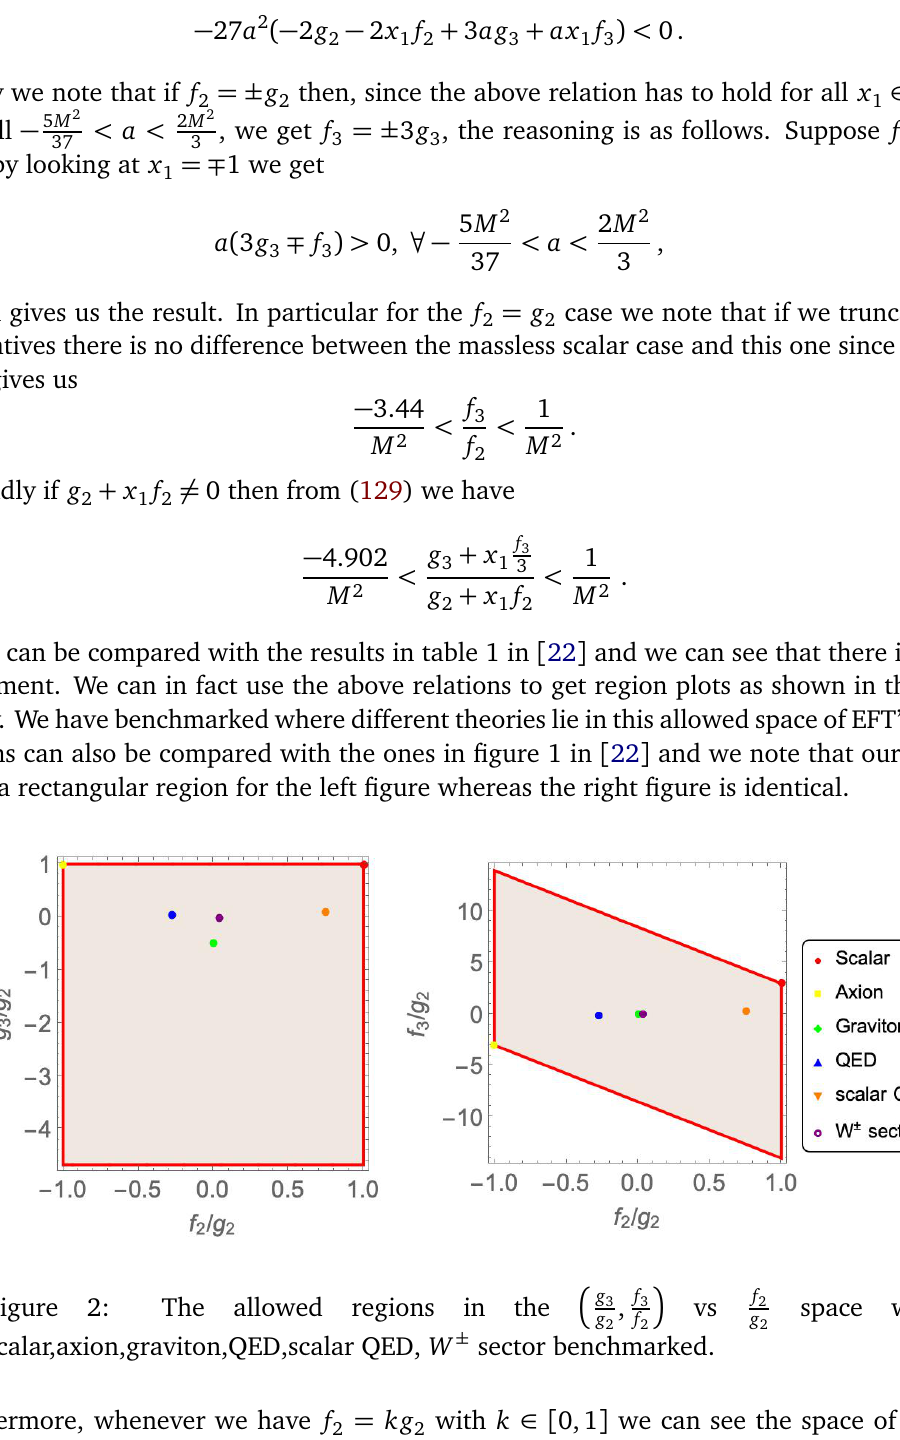
(cid:128) g (cid:138) 3 , f 3 vs f 2 space with g 2 g 2 f 2